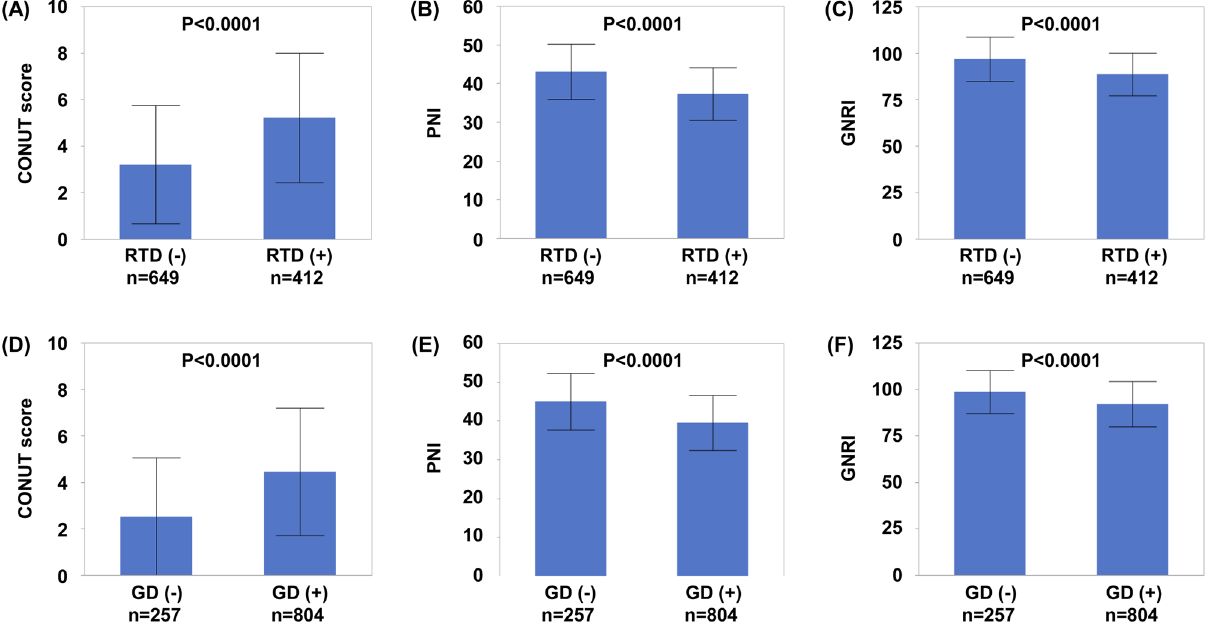
Figure 1. Association between malnutrition and renal dysfunction; ( A–C ) The association of RTD with CONUT score, PNI, and GNRI; ( D–F ) The association of GD with CONUT score, PNI, and GNRI. CONUT